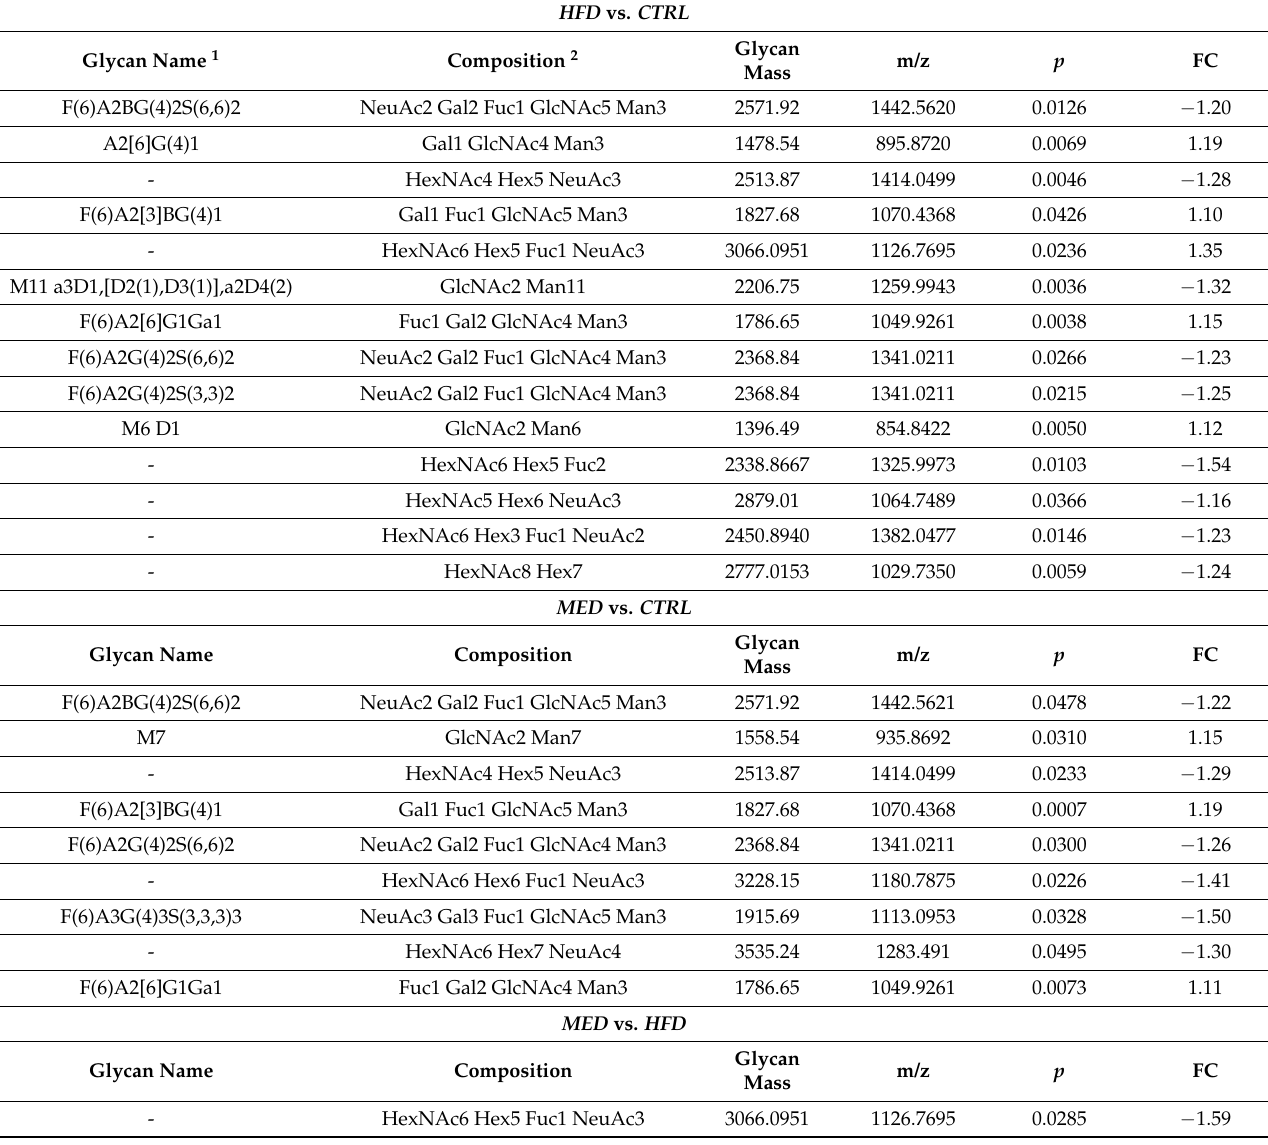
Table 3. Statistically significant brain N-glycans by week 12 in the three different pairs of conditions: HFD vs. CTRL, MED vs. CTRL, and MED vs. HFD. HFD, high-fat diet; CTRL, normal-fat diet; MED, Mediterranean-like diet; FC, fold change. HFD vs.